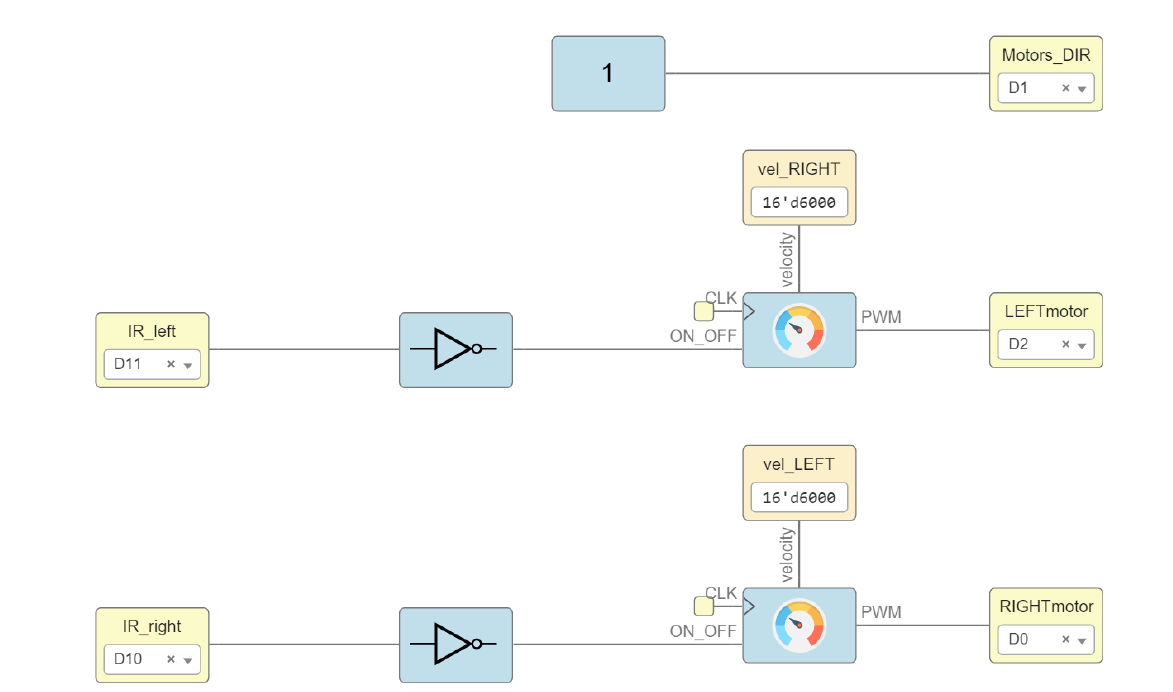
Figure 6. IceStudio circuit for Line Following